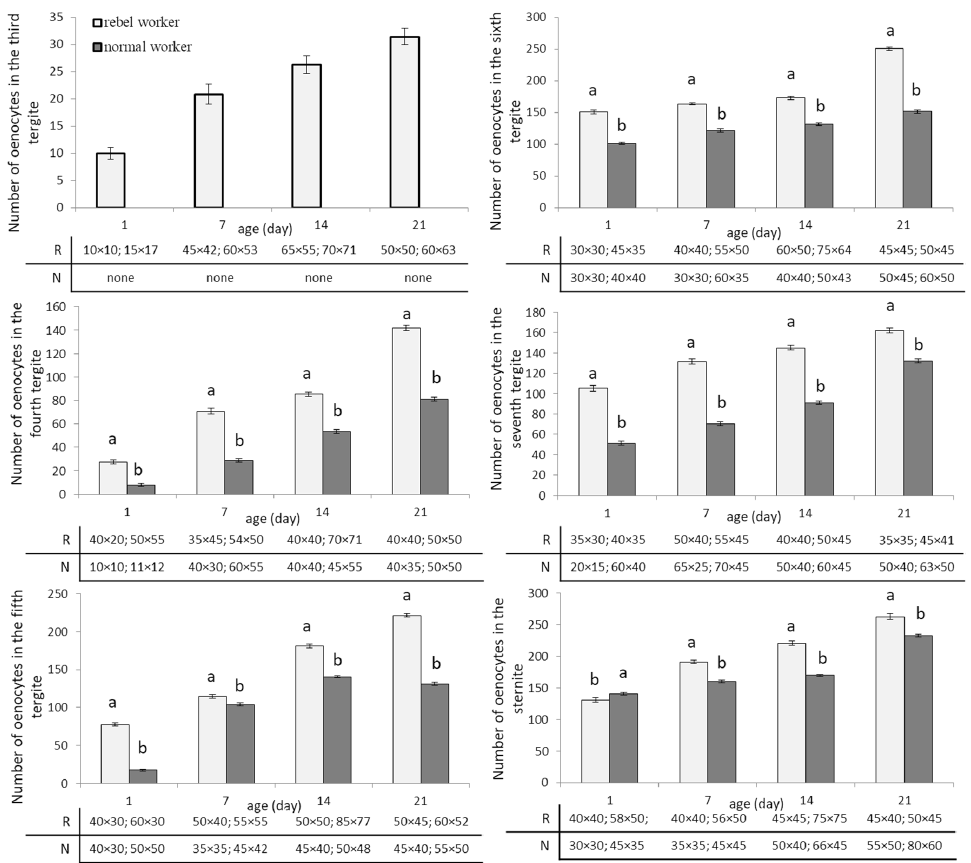
Figure 5. Number and size of oenocytes (mean ± SD) in the fat body from the third–seventh tergites and sternites in aging of rebel and normal workers. The tables below each small graph show the sizes (length × width) of the smallest and largest oenocytes in the fat body of a particular segment. Lowercase letters indicate significant differences between av- erages for the rebels and normal workers within a specific age with p < 0.01; R—rebels; N—normal workers.